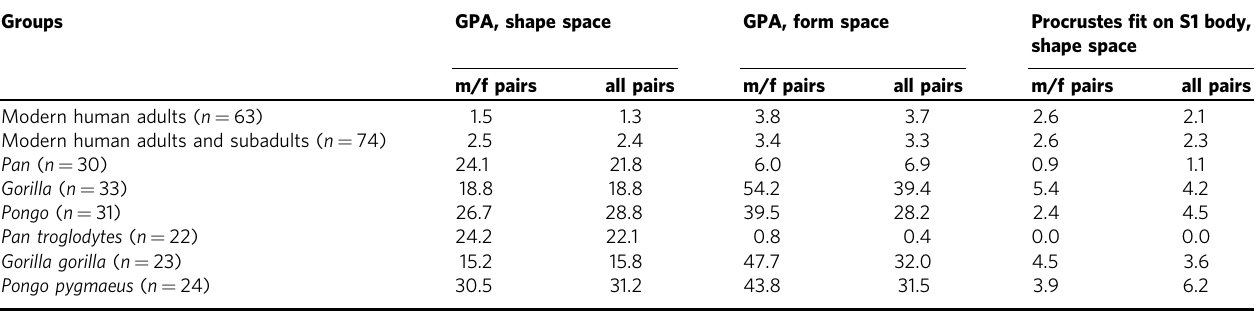
Table 1 Percentages of the pairwise Procrustes distances that exceeded the Procrustes distance between StW 431 and Sts 14. Groups